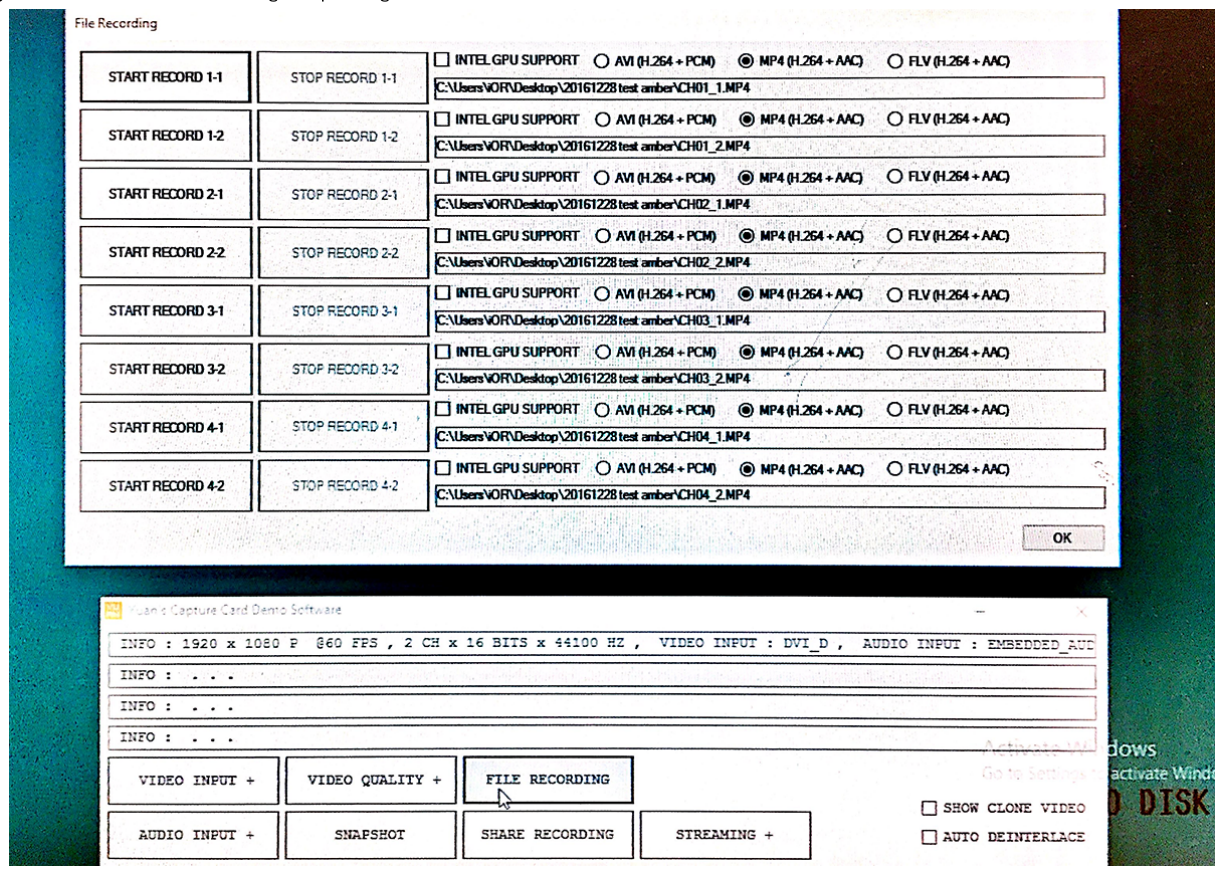
Figure 4. Screenshot of the intelligent operating room